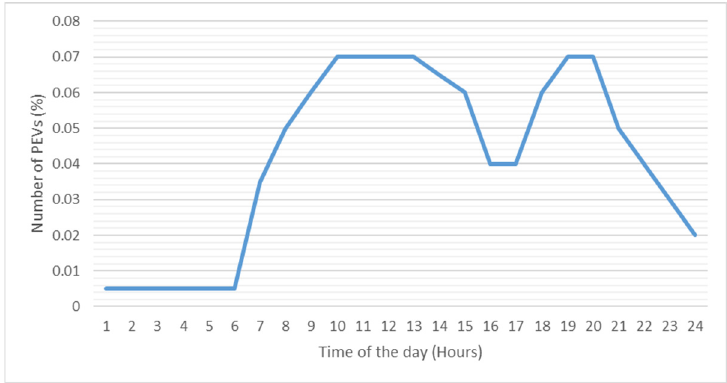
Figure 1. PEV arrival profile.